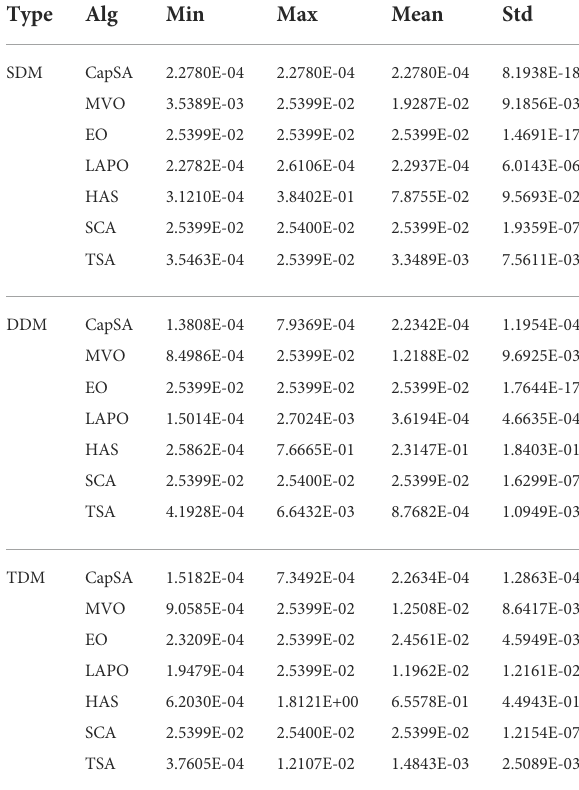
TABLE 5 Statistical parameters of the approaches applied to PVM752 PV cell.